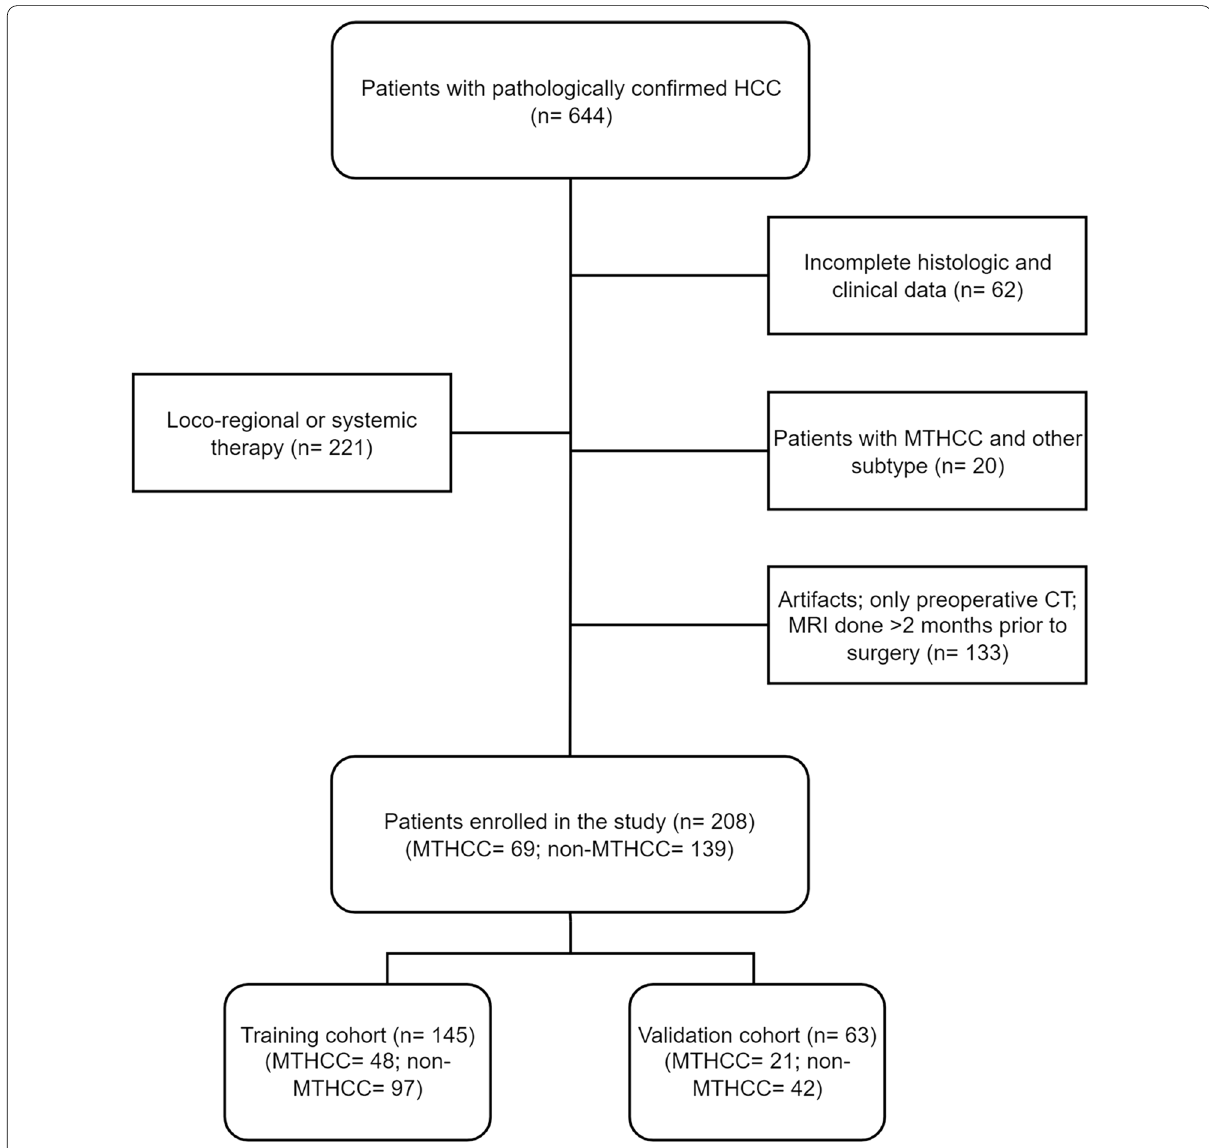
Fig. 1 Flow diagram of patient